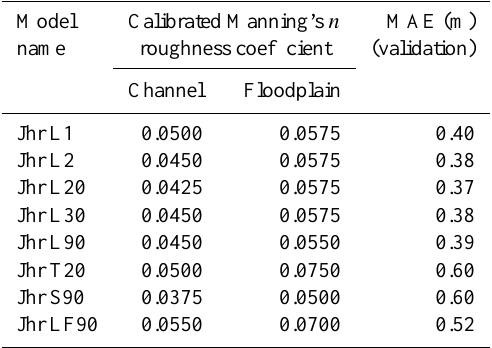
Table 5. Model validation results.